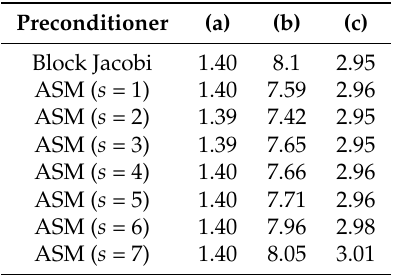
Table 1. Simulation times ( s ) for shell Partitioner (ASM: additive Schwarz